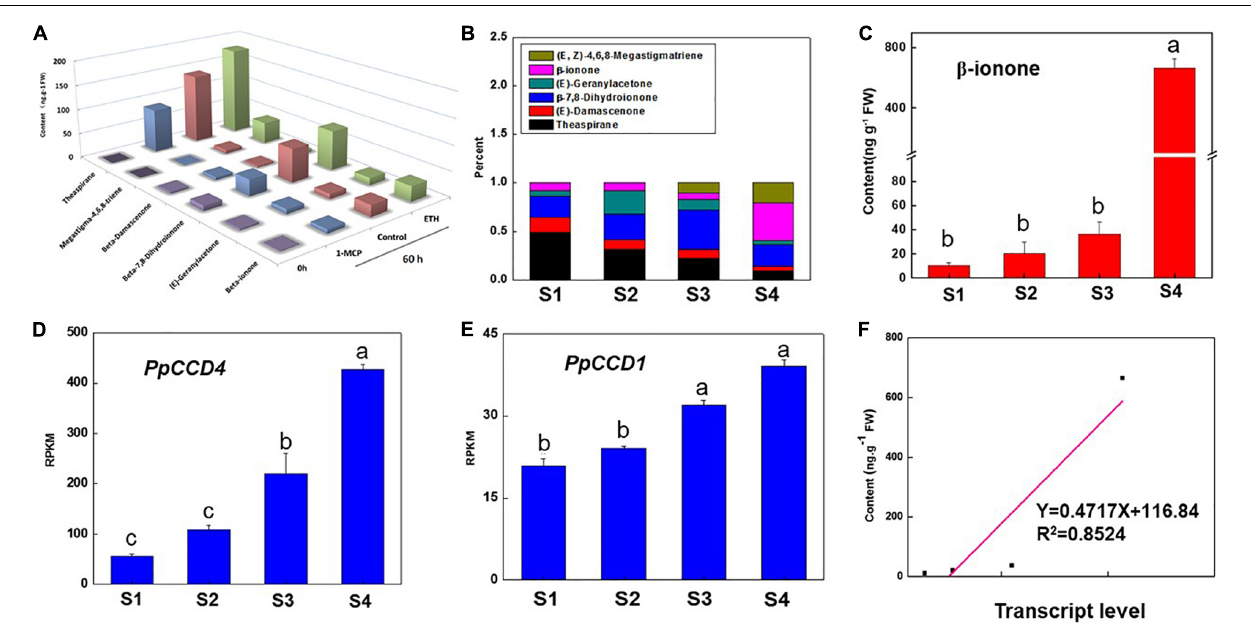
FIGURE 1 | Change of the apocarotenoid volatiles and transcript level of PpCCD4 during peach ripening. (A) Change of apocarotenoid volatiles under ethylene treatment. (B) Percentage change of the apocarotenoid volatiles under different ripening process, S1 represents 110 days after bloom (DAB), S2 represents 113 DAB, S3 represents 116 DAB, and S4 represents fruits that were stored at room temperature for 3 days. (C) Change of β -ionone content. (D) Transcript patterns of PpCCD4 . (E) Transcript patterns of PpCCD1 . (F) Correlation analysis between β -ionone content and transcript levels of PpCCD4 . Different letters indicate the significant difference with Duncan’s multiple range tests at p <